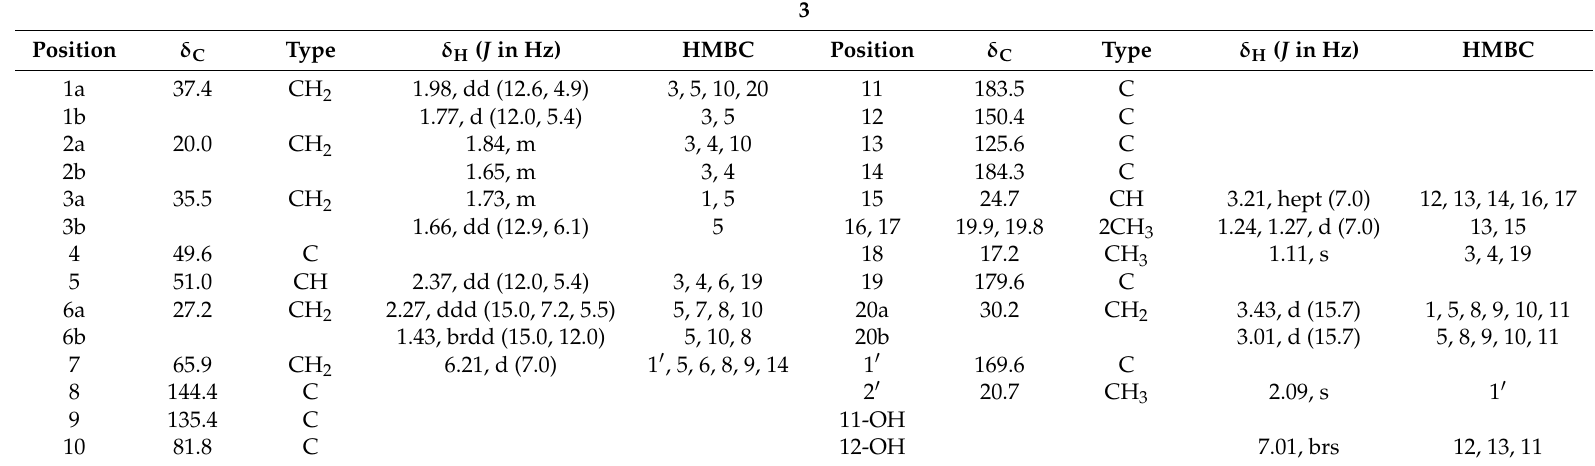
Table 2. NMR data ( 1 H 700 MHz, 13 C 175 MHz, CDCl 3 ) of 3 .